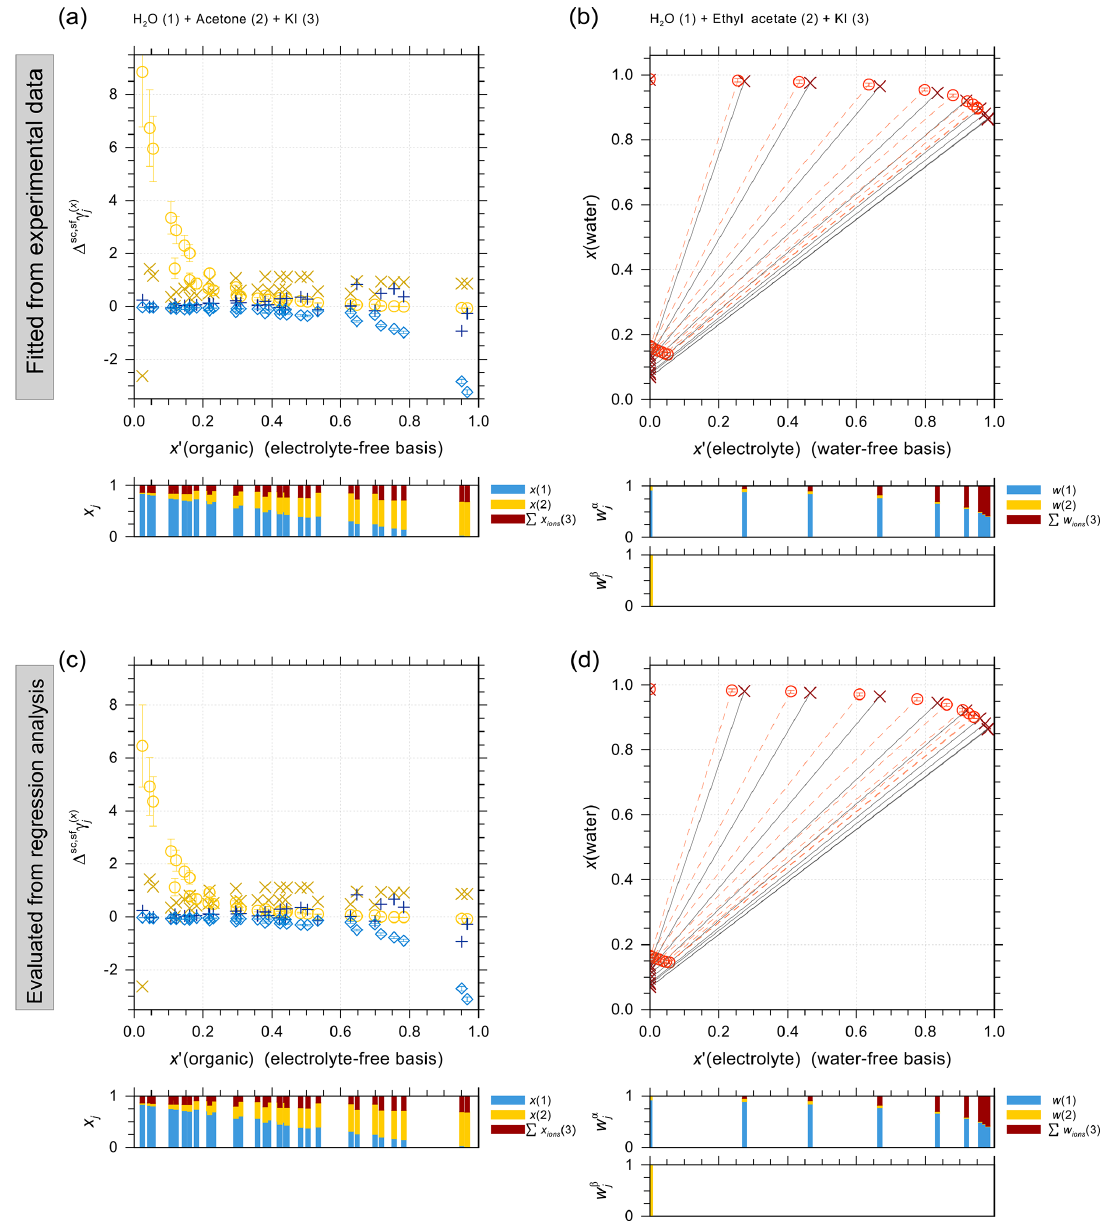
Figure 12. Comparison of experimental data ( × , + ) and predicted ( ◦ , (cid:5) ) values for ternary systems using two different approaches for the iodide interaction parameters within AIOMFAC. Predictions from the left and right panels are based on fitted parameters from experiments (top) and our regression approach (bottom). (a,c) VLE of water (1) + acetone (2) + KI (3) at 322–360K; experiments by Al-Sahhaf and Jabbar (1993). (b, d) LLE of water (1) + ethyl acetate (2) + KI (3) at 298K; experiments by Al-Sahhaf et al. (1999). The composition bars show the mass fractions (b,d) or the mole fractions (a,c) of the components with respect to dissociated